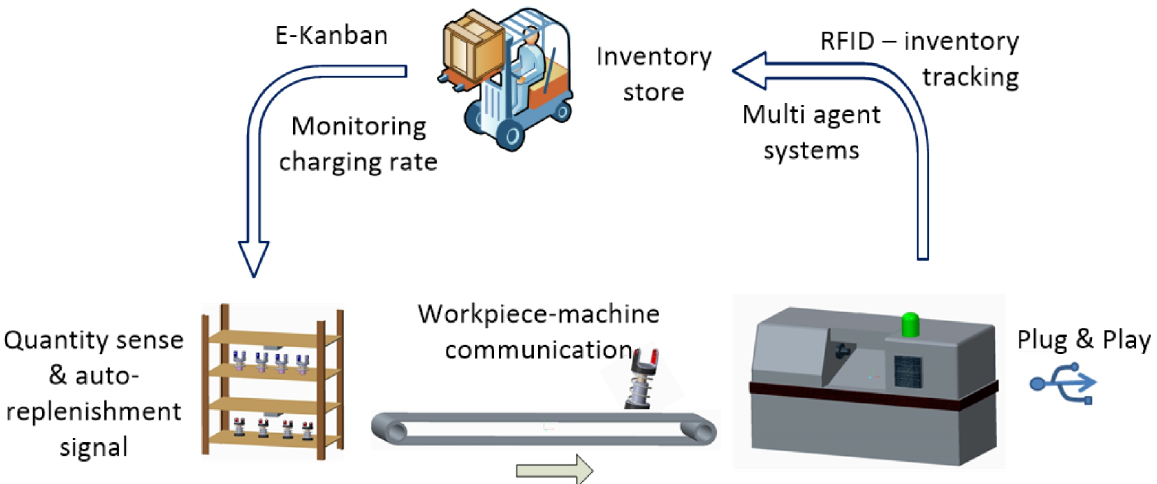
Figure 4. Impact of Industry 4.0 on process